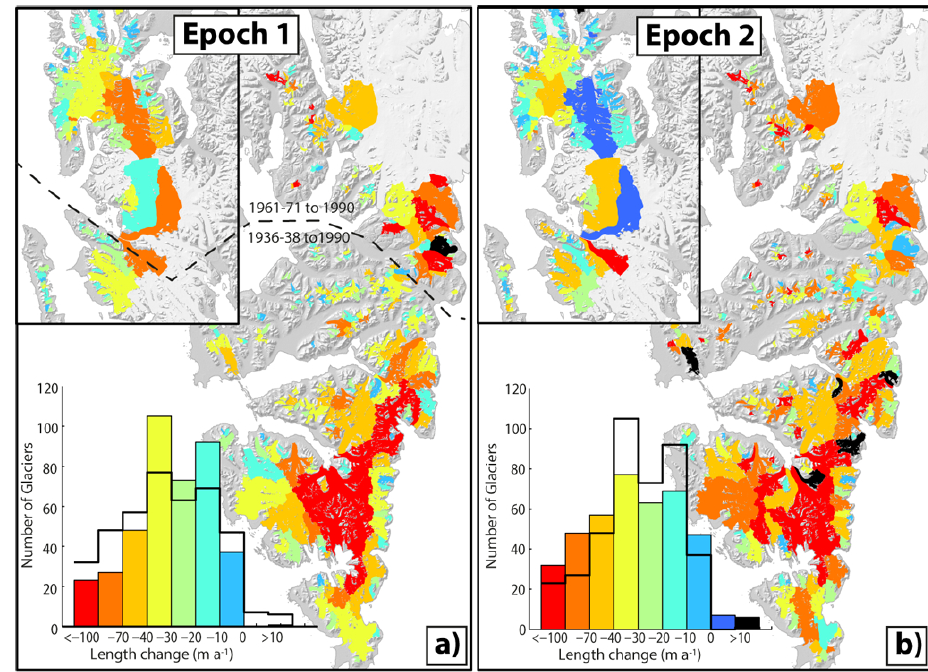
Fig. 8. Average length change rates calculated using the “area/width” method between (a) GI old and GI 90 and (b) GI 90 and GI 00s . The inset map is a section of northwest Spitsbergen. The histogram insets show the number of glaciers for each color used in the map. The straight bar line in the histograms are of the alternate epoch for comparison. The distribution of Epoch 2 length changes is more negative than that of Epoch 1.